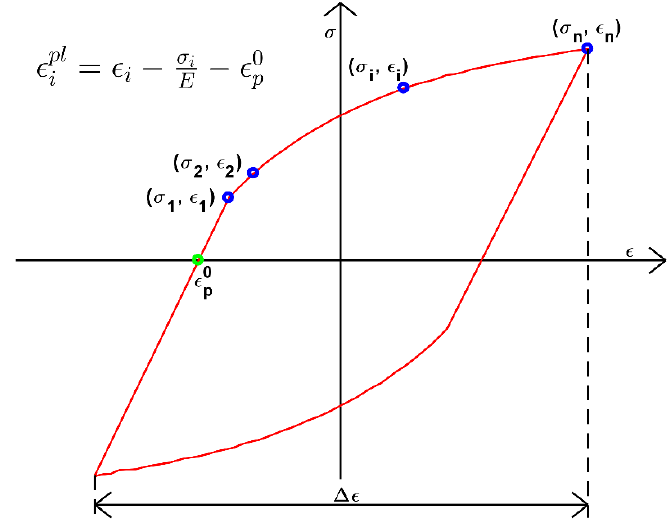
Figure 3. Calibrating the kinematic hardening, ( σ i , ε i ) pairs to the N25/2 loop. Point ( σ 1 , ε 1 ) is the end of the linear elastic region, following the un-loading half of the loop.